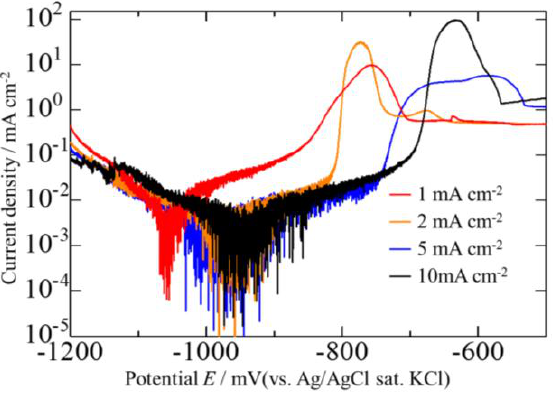
Figure 11. Anodic polarization curves of the Zn–Fe–Mo platings deposited at various current densities.